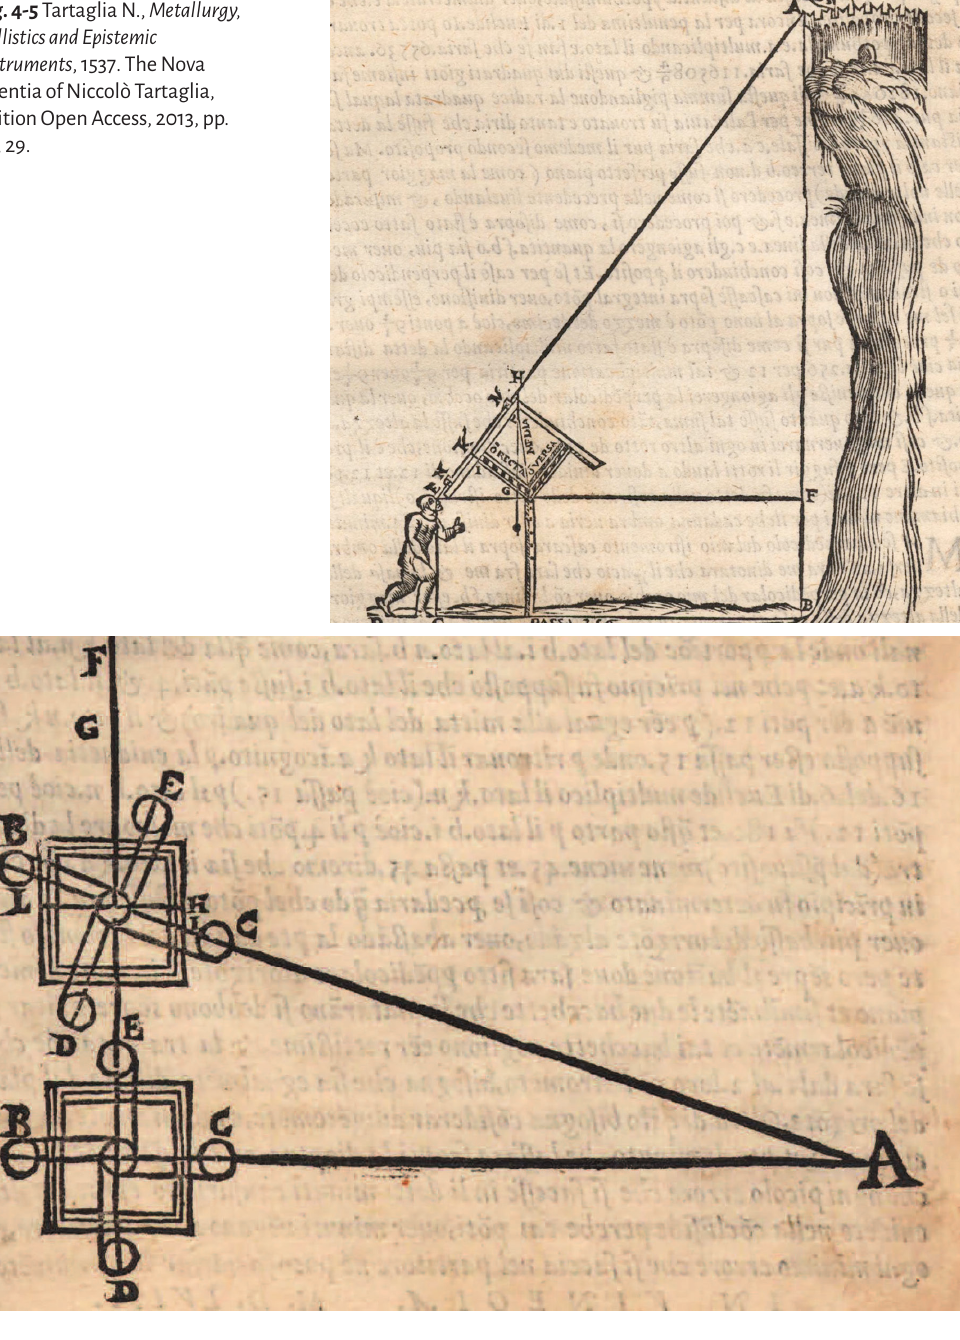
Fig. 4-5 Tartaglia N.,